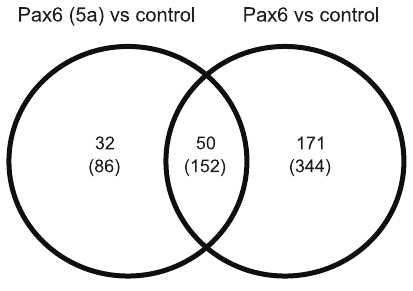
Figure 2. Venn diagram shows the number of individual and common sets of genes regulated by Pax6 and Pax6(5a) in a gene expression microarray. Three RNA samples from the FlpIn-3T3 control cell line, three samples from the FlpIn-3T3 Pax6(5a) cell line and two samples from the FlpIn-3T3 Pax6 cell line were sent for microarray analysis on the Illumina Mouse Ref-8 V1.1 chip. The number of genes differentially regulated as scored by threshold 1 is shown, while use of threshold 2 gave numbers shown in parentheses. (Threshold 1 is FDR p-